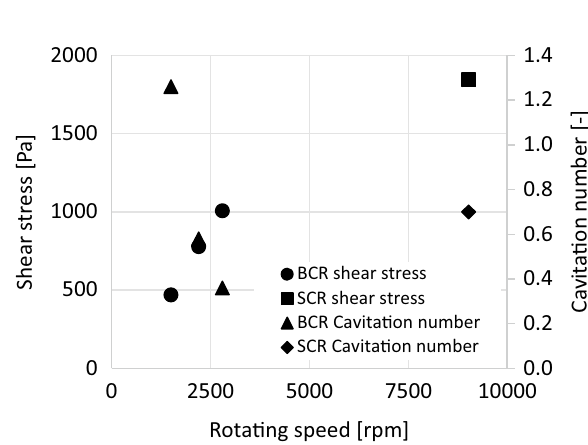
Figure 5. Shear stress distribution plot of SCR (left) and BCR (right).